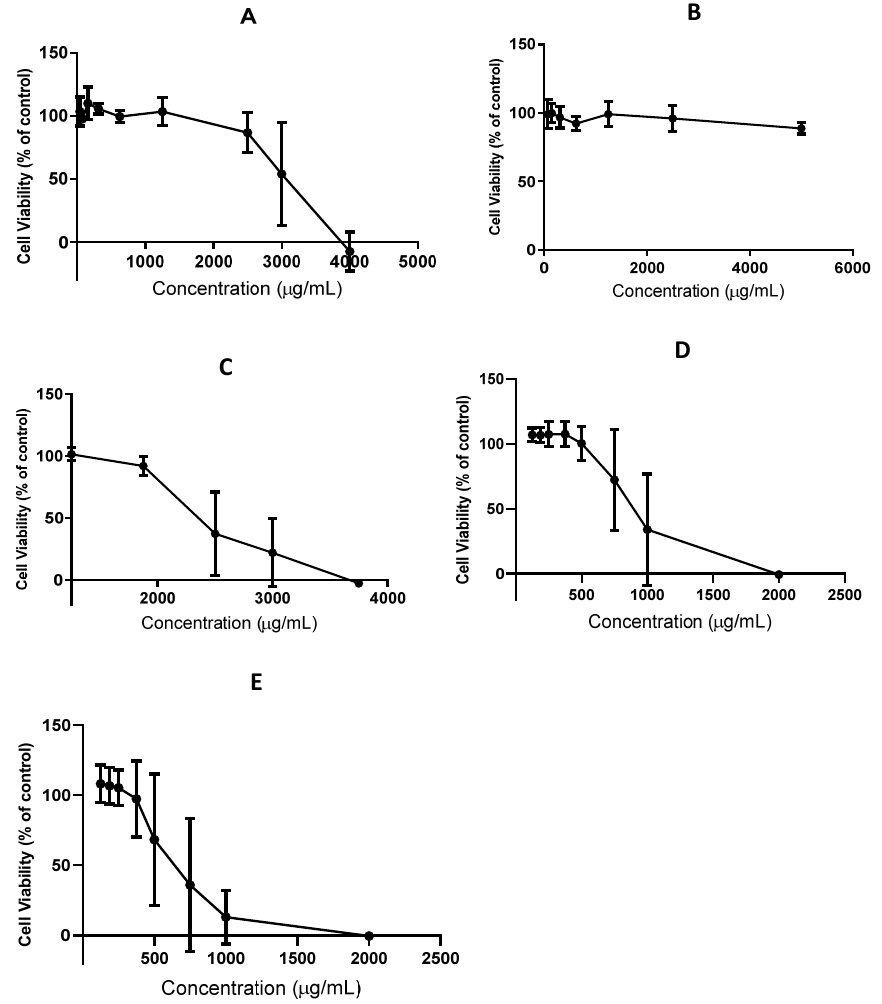
Figure 5. Cytotoxic profile of chicory extracts in Caco-2 cells after incubation for 4 h. ( A ) Wit_EtOAc. ( B ) Wit_H2O. ( C ) Ci_EtOAc. ( D ) Ci_SFEopt. ( E ) Ci_SFEpur. Results are presented as mean (±stdev) of three independent experiments.